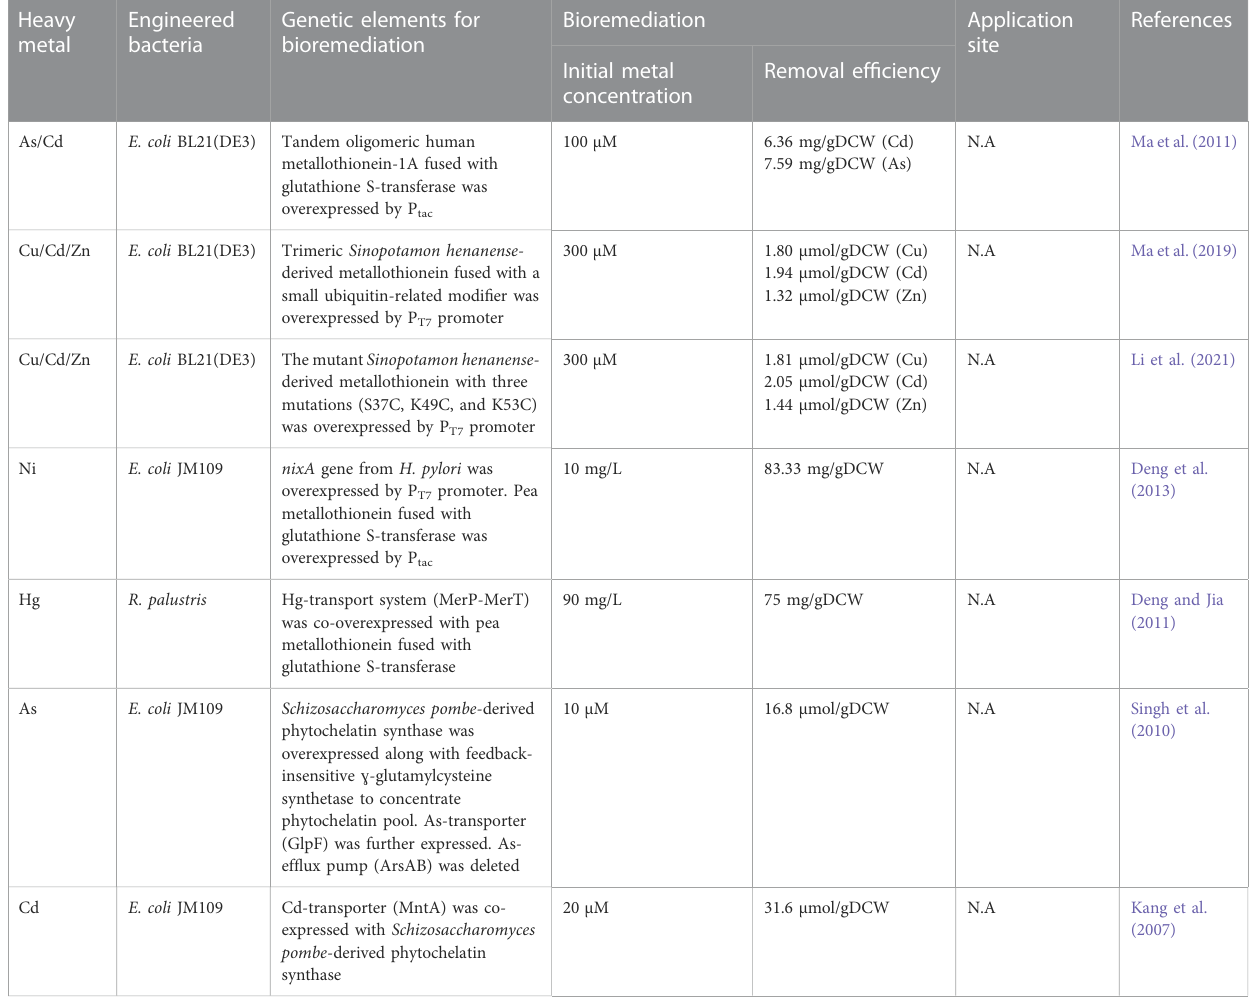
TABLE 4 ( Continued ) Synthetic biology approaches applied to heavy metal bioremediation in